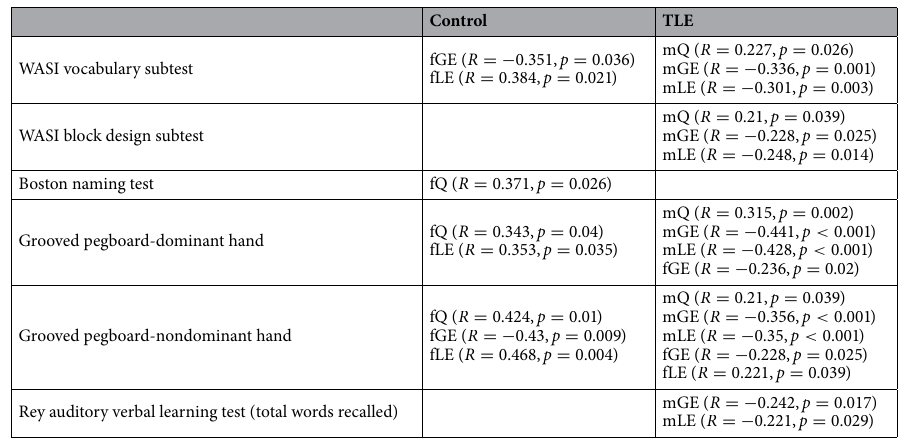
Table 2. Significant correlations between GT measures and cognition. f functional, m morphological, GE global efficiency, LE local